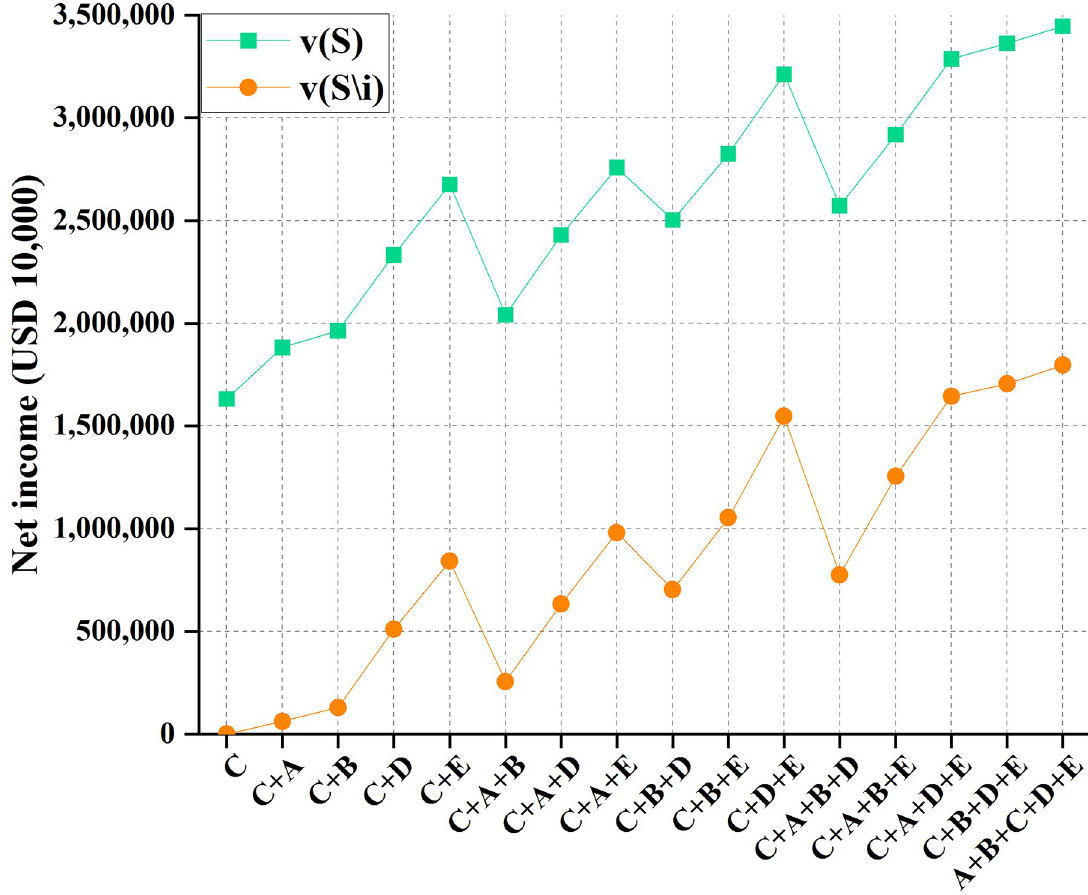
Fig 15. Profit comparison of 16 cooperation modes between Thailand and other four